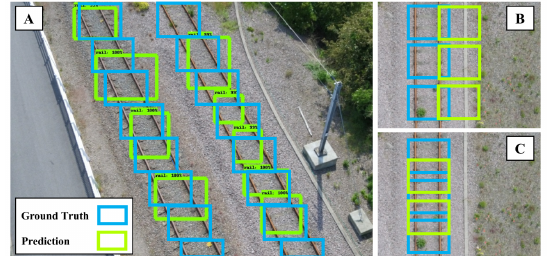
Figure 3: Issues relating to Intersection over Union (IoU) accuracy measurement. A) Unfortunate positioning of ground truth boxes results in the image having an accuracy of 50%@IoU=0.5. In the image a total of 78% of the railway track is covered by prediction boxes. With an IoU=0.1 the accuracy is increased to 75% B) Limitations of IoU@0.1 metric. Although ~10% of railway track is detected the accuracy measurement would be 100%@IoU=0.1. C) Demonstration of more representative accuracy measurements.